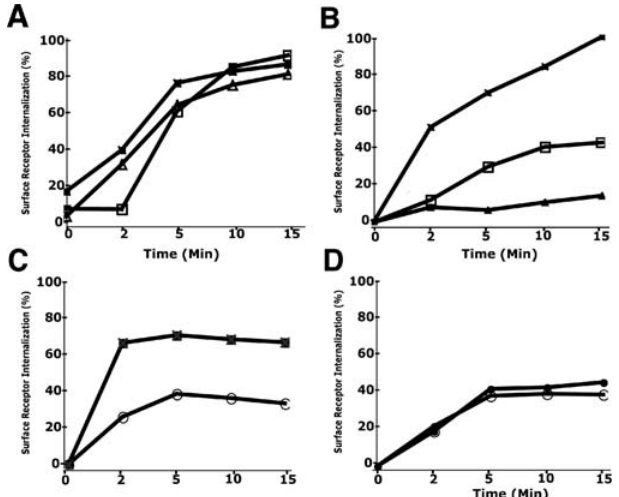
Figure 1. BCR Endocytosis Is Determined by Cytosolic Tyrosine-Based Motifs A20IIA1.6 cells expressing chimeras containing the cytosolic tail of either wild-type Ig a or Ig a in which the ITAM or non-ITAM tyrosines were mutated were assayed for endocytosis. (A) Comparison of Ig a wt (solid squares) to Ig a in which ITAM tyrosines were mutated to phenylalanines (Ig a Y D F182,193 ) (open triangles) or alanines (Ig a Y D A182,193 ) (open squares). (B) Comparison of the internalization of Ig a wt (solid squares), a cytosolic tail truncation of Ig a ( D T, open triangles), and a ITAM/non-ITAM Ig a mutant (Ig a Y D A176,182,193,204 , open squares). (C and D) Ig a wt (C) or Ig a Y D A176,182,193,204 (D) were assayed for endocytosis in the presence (closed symbols) or absence of Latrunculin A (open symbols). DOI: